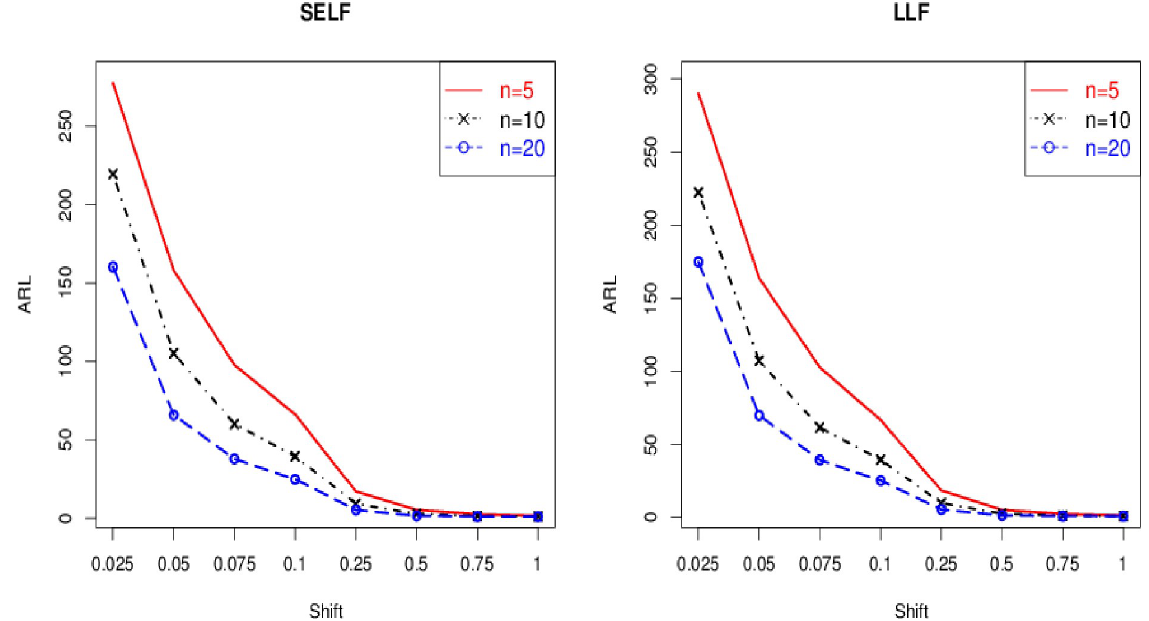
Fig 3. ARL curves under different sample sizes using λ = 0.05 and ARL 0 = 370.